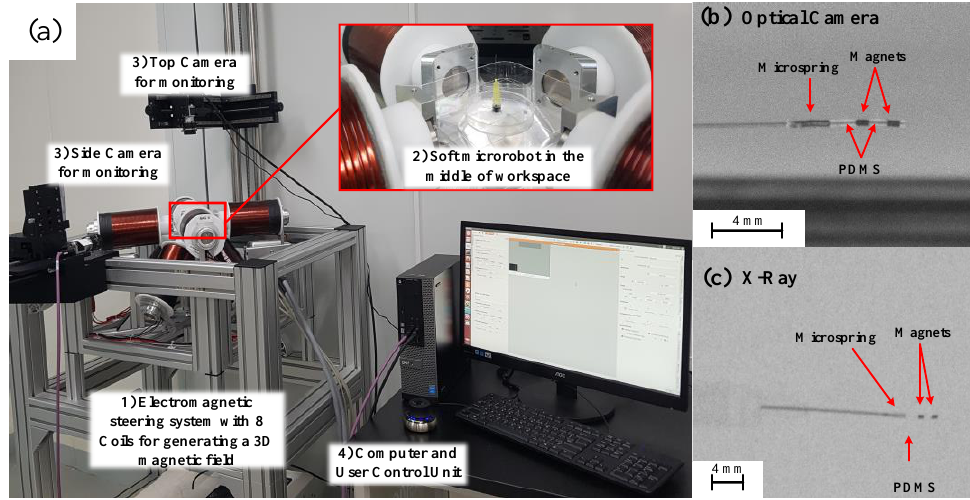
Figure 2. ( a ) The experimental setup for microrobot steering with the OctoMag system, ( b ) Optical image of the microrobot, ( c ) X-ray image of the microrobot.